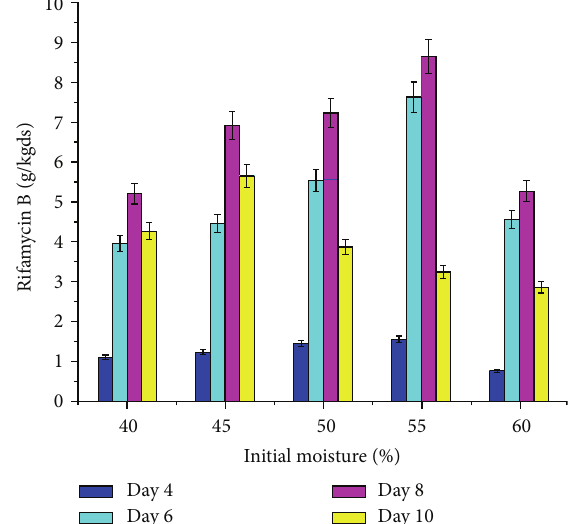
Figure 5: Effect of various levels of moisture (%) on rifamycin B production by Nocardia mediterranei MTCC 14 using sunflower oil cake under solid-state fermentation.